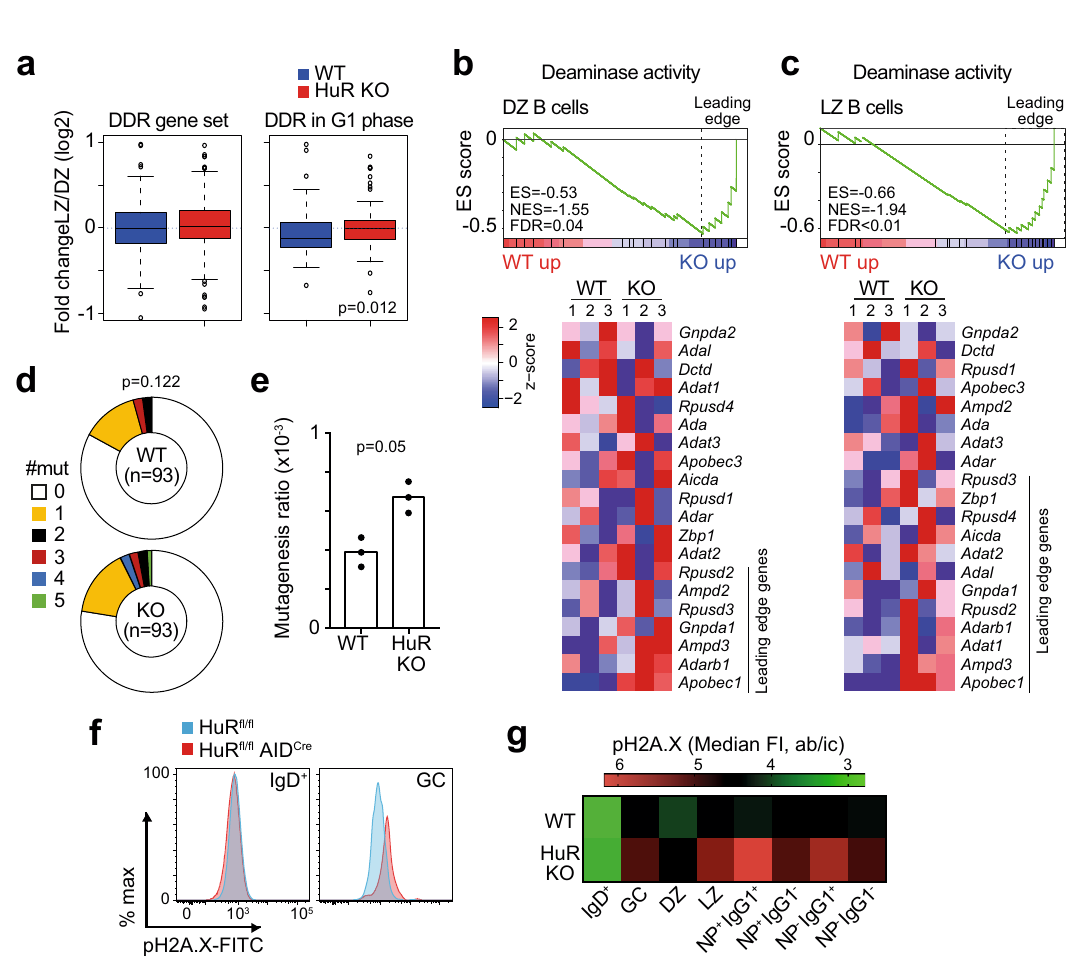
Fig. 8 DNA damage is increased in the absence of HuR. a Change in the global expression of genes associated with the DNA damage response ( n = 119 genes in DDR gene set from Reactome, n = 56 genes in DDR in G1 phase) in LZ and DZ GC B cells (data presented as box plots showing the mean, 25 – 75% range and whiskers from 5 to 95%, two-sided Wilcoxon test). b , c Enrichment analysis of genes involved in deaminase activity (GSEA, Gene set GO:0019239) in DZ GC B cells ( b ) and LZ GC B cells ( c ). Top panels, enrichment plot showing the gene enrichment score (ES), the normalised enrichment score (NES) and the false discovery rate (FDR). Bottom panels, heatmap showing the relative expression of genes involved in deaminase activity in DZ and LZ GC B cells at day 7 after immunisation with NP-KLH in alum. Leading genes driving increased deaminase activity in HuR KO GC B cells are indicated in blue. d Analysis of SHM in GC B cells sorted from HuR fl / fl and HuR fl / fl AID Cre mice at day 7 after immunisation ( n = 93 clones analysed per mouse genotype, two-sided Mann – Whitney test). e Quantitation of the mutagenesis ratio in the JH4 intron ( n = 3 mice processed independently in different experiments, two-sided Mann – Whitney test). f Flow cytometric histograms showing the expression of pH2A.X (pS139) in naive and GC B cells from HuR fl / fl and HuR fl / fl AID Cre mice at day 14 after immunisation (data representative from 1 of the 2 independent experiments performed, n = 6 – 9 mice per group). g Heatmap of pH2A.X MFI in the cell types indicated (data is from 2 independent experiments, n = 11 – 16 mice per group). Source data are provided as a Source data fi